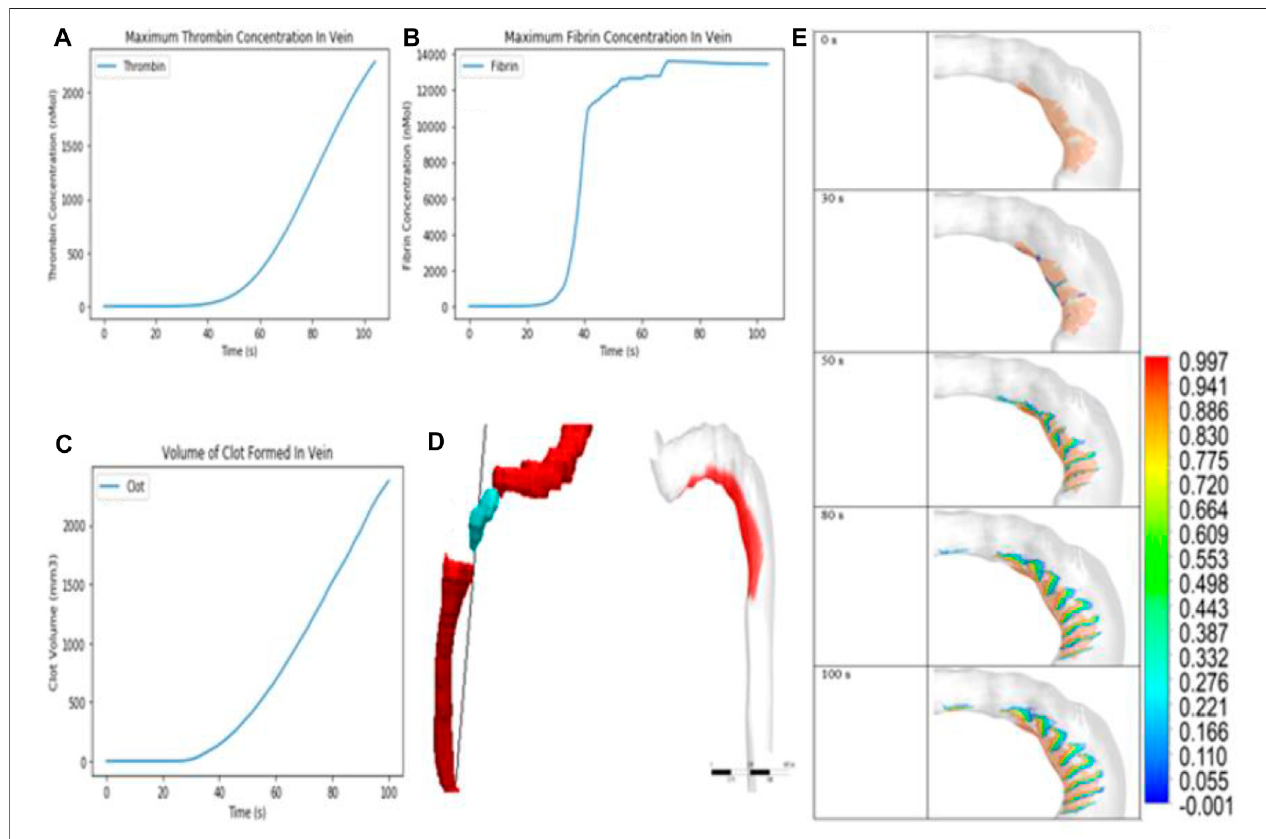
FIGURE 15 | (A,B) Maximum thrombin and fi brin concentration in the vein over 100s. (C) Volume of clot formed in the vein over 100s. (D) Comparison between in vivo and in silico clot. (E) Contour showing clot growth over t = 100 s. Scalar = 1 for clot core and > 0.5 for clot shell (patient-speci fi c